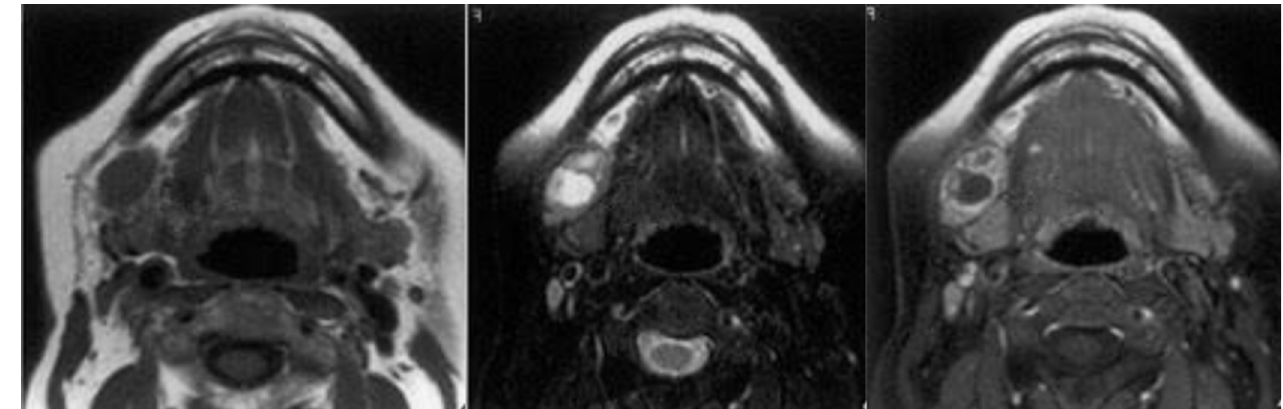
Fig. 1. Cervical nodal necrosis observed in MRI studies of a patient diagnosed with squamous cell carcinoma